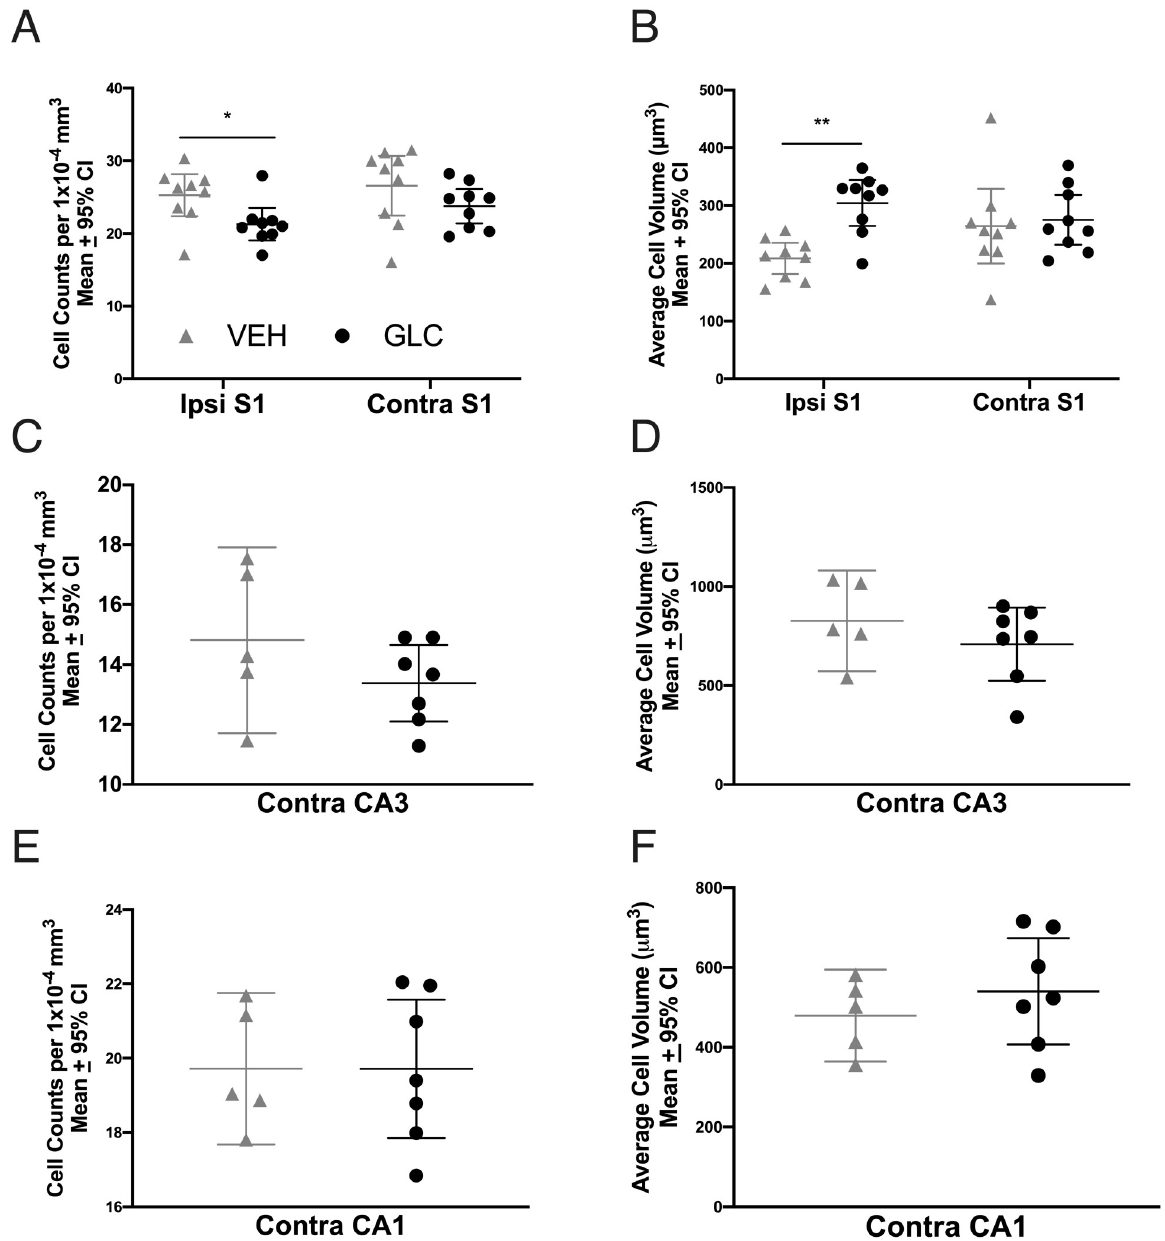
Fig 7. Experiment 3 cell shrinkage. In S1, glibenclamide had a large effect on cell density in the ipsilateral (Ipsi) injured hemisphere of glibenclamide treated rats, compared to the contralateral (Contra) hemisphere (A, p = 0.037). Additionally, glibenclamide had a large effect on cell volume in the ipsilateral hemisphere (B, p = 0.0017). No effect of glibenclamide was found on either cell density or volume in CA3 or CA1 (C-F, p � 0.2276), suggesting that this agent did not affect tissue compliance. Since brain water content was similar across groups, this indicates that glibenclamide worsened cytotoxic edema. � p < 0.05, �� p <